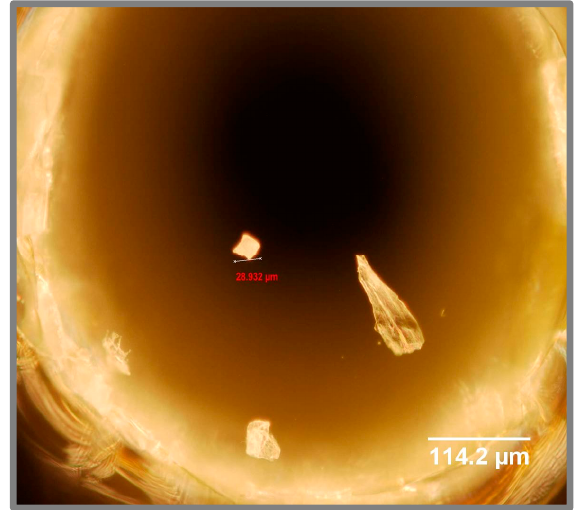
Figure 4. Microscope picture of the inlet hole made from a drilling machine with resulting shards falling off the fused silica surface.